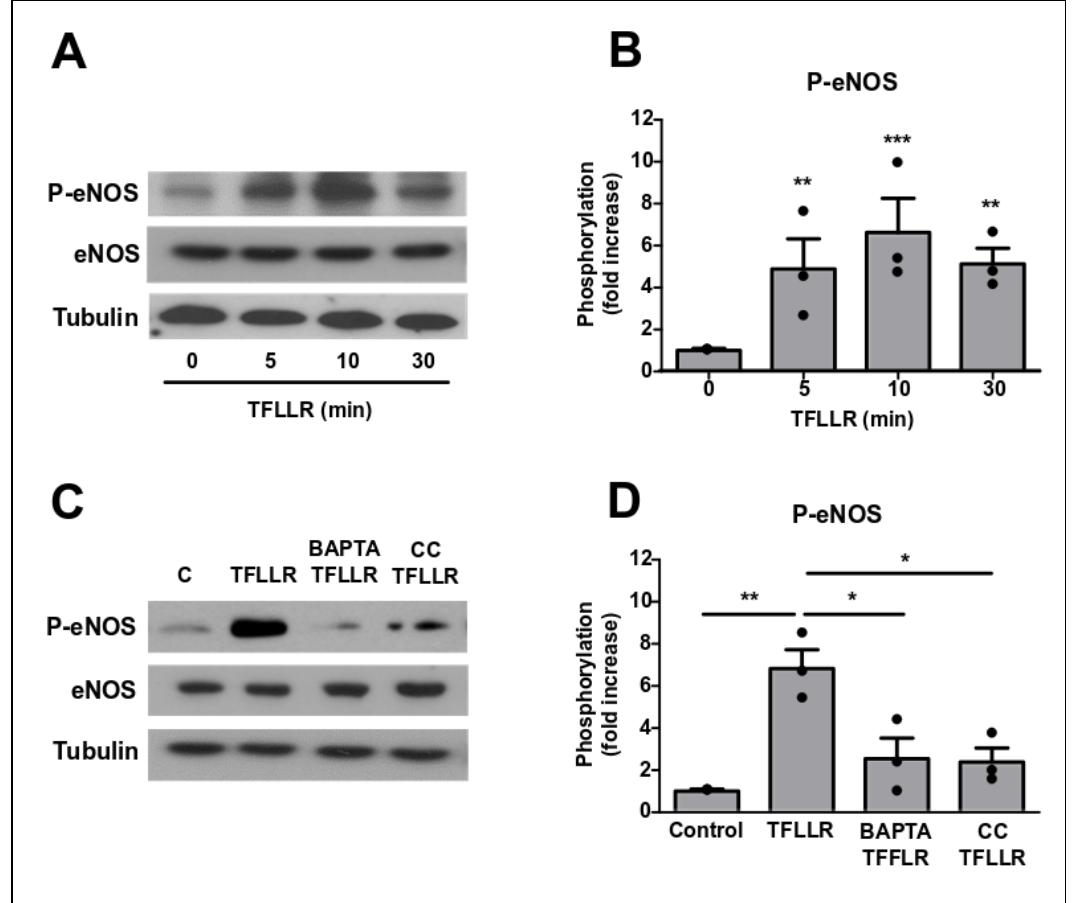
Figure 5. PAR1 activation in BBB endothelial cells leads to eNOS activation. ( A , B ) GPNT were stimulated with 100 µM TFLLR for the indicated length of time before eNOS phosphorylation was analysed by western blot. ( C , D ) GPNT were incubated with BAPTA (20 µM) or Compound C (10 µM) for 15 min and then treated with TFLLR for 5 min. Phosphorylation of eNOS was assessed by western blot. Representative results and quantification of protein phosphorylation, normalised to total protein levels, from three independent experiments are shown as normalised means ± SEM. Each data point represents one independent, biological replicate. Significant differences from controls were determined by ANOVA and Dunnett’s and Tukey’s post-hoc analysis with * p < 0.05, ** p < 0.01, *** p < 0.001.